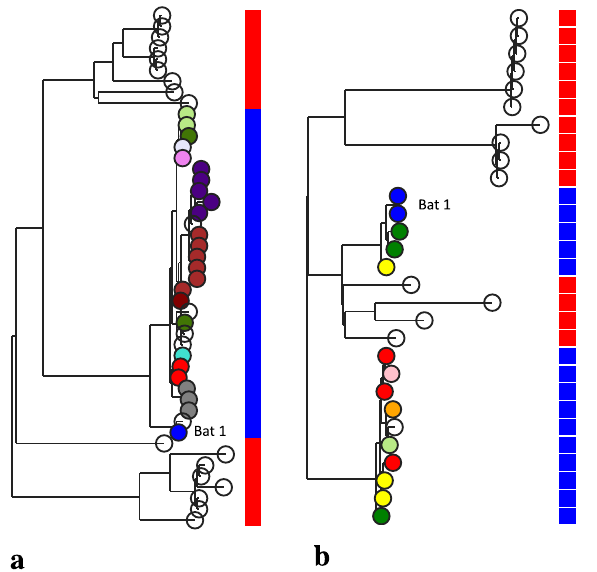
Figure 2. Phylogeny of isolates recovered from captive (coloured nodes, blue squares) and free-ranging bats (open nodes, red squares). For the former, colours of the nodes represent the individual captive bats. ST1 isolates are shown in ( a ), and ST3926 isolates are in ( b ). Clusters of very similar ST1 isolates are noted in the ‘purple’ and ‘brown’ bats. In some cases individual bats harboured isolates corresponding to different clusters. Isolates from one of the original founding bats are indicated (Bat 1).